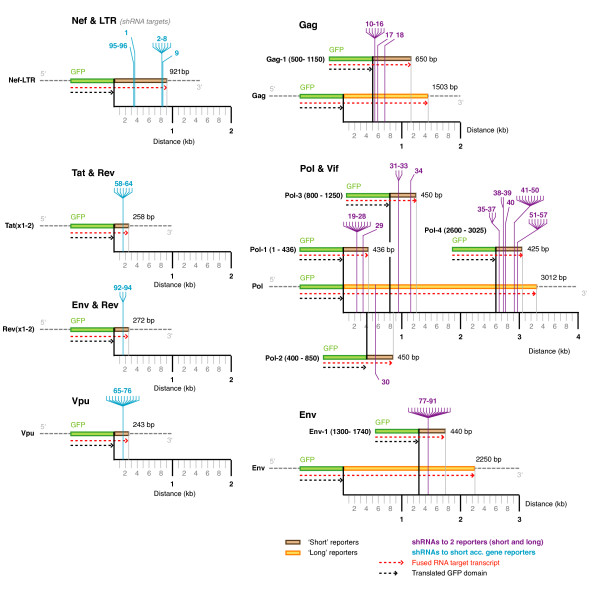
shRNA target sites mapped to the 13 fluorescent reporters. The target sites of the 96 shRNAs were mapped to the 13 fluorescent reporters. The 4 short accessory genes and LTR reporters are shown down the left, and the 3 long core gene reporters are shown down the right. Mapped onto the long core gene reporters were the corresponding 6 short gene fragment reporters made to retest the core gene shRNAs. Lengths are to scale to show the relative distances between the target sites, fusion junctions and total reporter lengths. n.b. some shRNAs were assayed with a different reporter to that of the gene targeted due to overlapping target sequences, e.g. the Vif matched shRNAs #51 – 57 were assayed with Pol reporters.